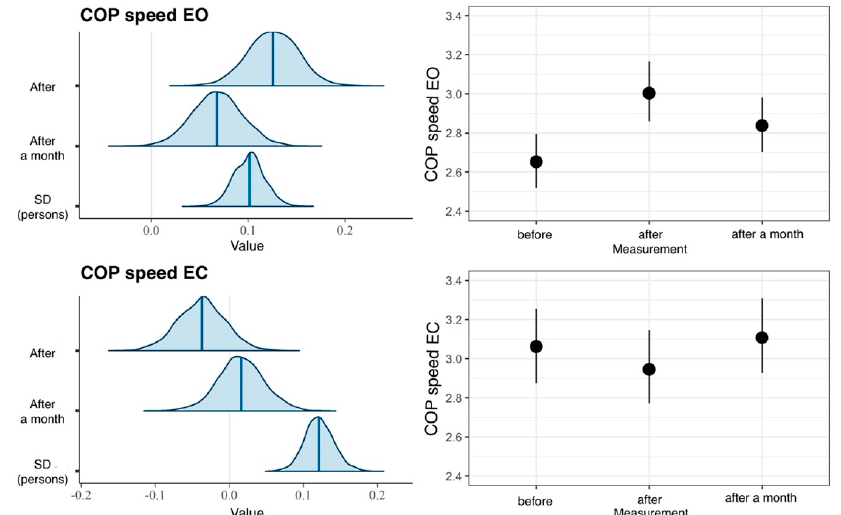
Figure 10. Results of hierarchical two-dimensional regression analysis: the dependent variable is the COP sway velocity, and the main effect is the measurement in the experimental group. Left panels: a posteriori distributions of regression coefficients. Shaded areas denote 95% confidence level. Right panels: estimated marginal means. The points denote a posteriori distribution mean values, and vertical lines represent 95% confidence intervals. COP—center of pressure; EO—eyes open; EC—eyes closed.